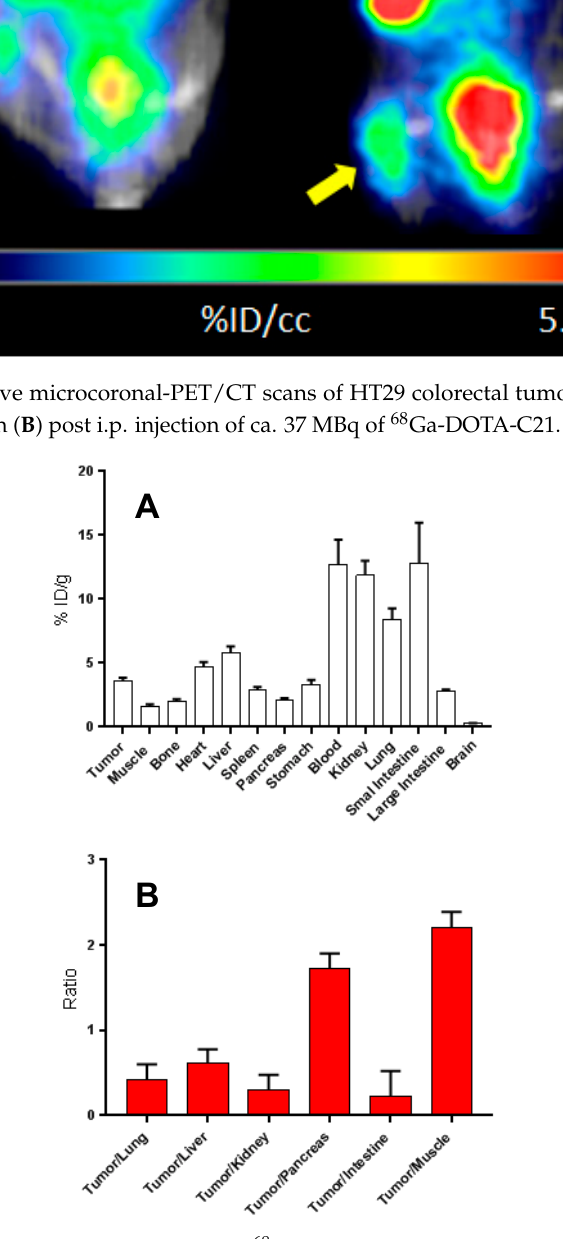
Figure 9. Biodistribution in multiple organs of 68 Ga-DOTA-C21 in HT-29 colorectal cancer bearing nude mice ( n = 5, mean ± SD) at 90 min post i.v. injection. ( A ). Ratios of the tumour uptake to major organs ( n = 5, mean ± SD) for 68 Ga-DOTA-C21 at 90 min post i.v. injection ( B ). 2.6. Metabolism Mouse blood was drawn 1.25–1.5 h post injection, processed and analysed by radio-HPLC. Out